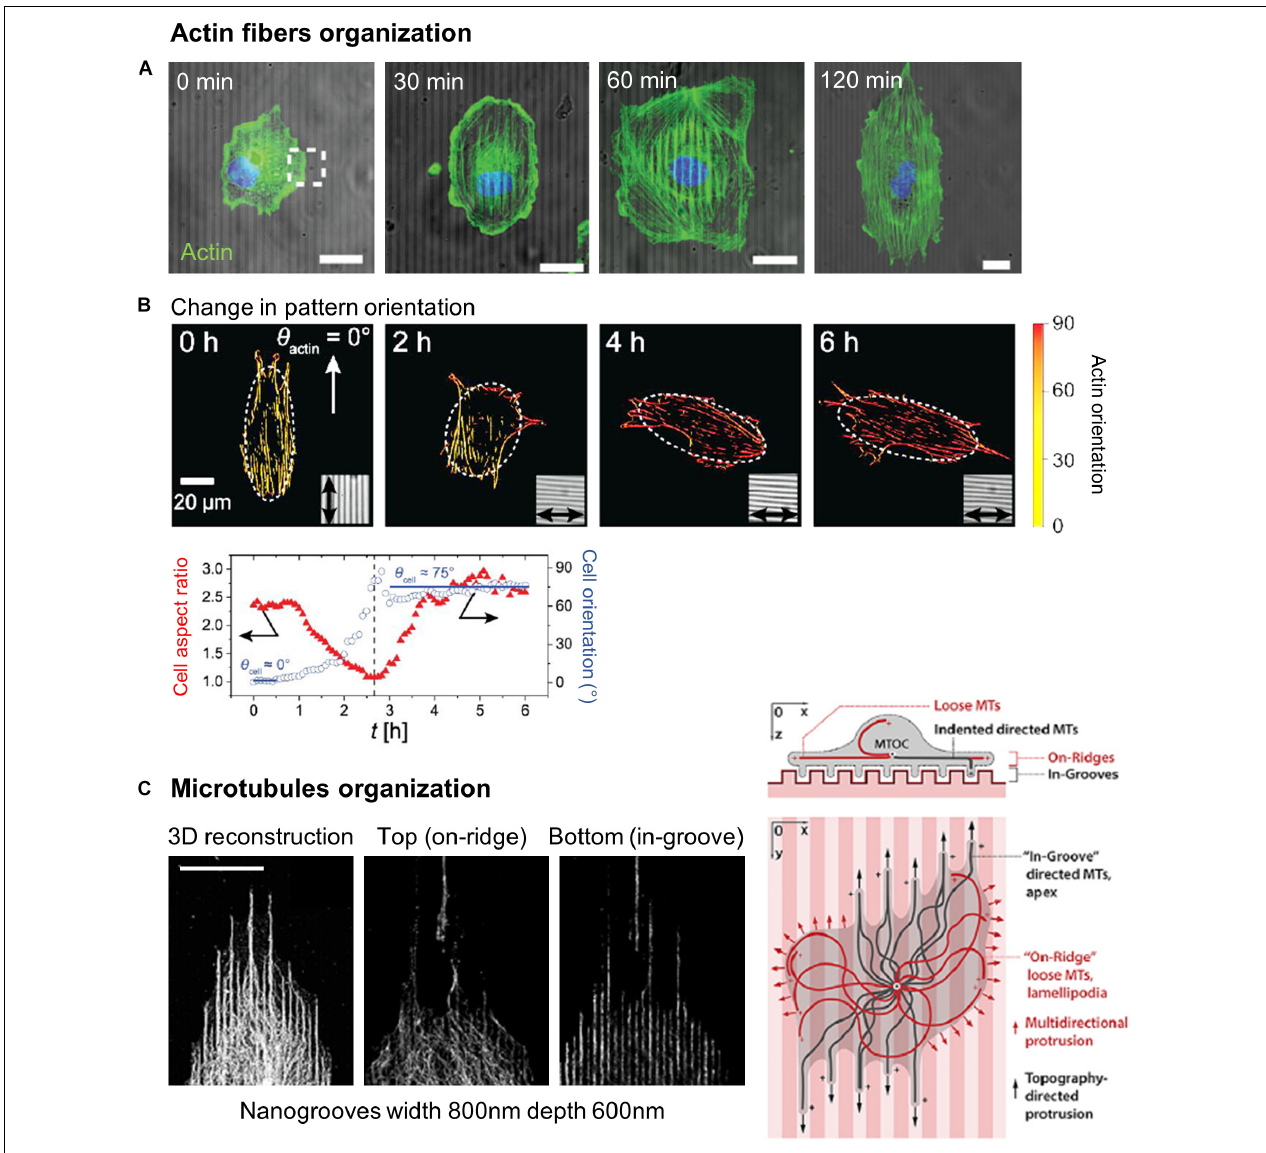
FIGURE 7 | Cytoskeleton organization on microstructured substrates. (A) Actin staining of endothelial cells on 2 µ m wide, 350 nm deep grooves at different time points showing actin fibers alignment shortly after cell orientation along the grooves. Scale bars 20 µ m. From Sales et al. (2017) published by the Royal Society of Chemistry. (B) C2C12 myoblasts transfected by LifeAct-GFP on microwrinkles substrates. After 2 h, the orientation of the wrinkles is changed by 90 ◦ . Actin orientation closely follows cell reorientation quantified by the cell orientation (red) and aspect ratio (red). Reprinted with permission from Linke et al. (2019). Copyright 2016 American Chemical Society. (C) Microtubules network organization in cancer cells on grooves reveals a loose “on ridge” network and a “in groove” directed network. Scale 20 µ m. From Tabdanov et al.